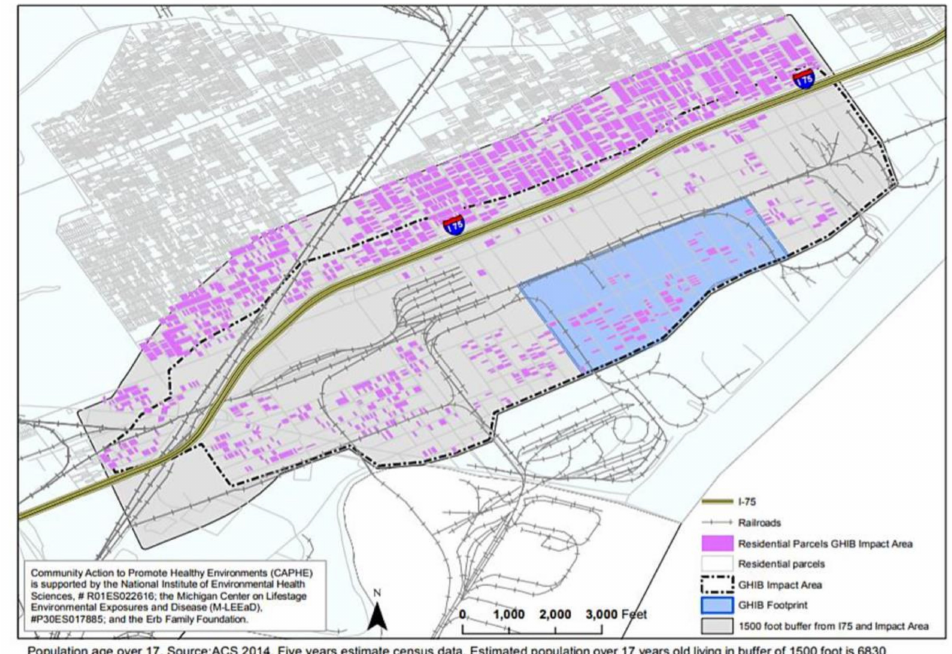
Figure 5. Gordie Howe International Bridge Survey area: Residential parcels in impact area and 1500-foot bu ff